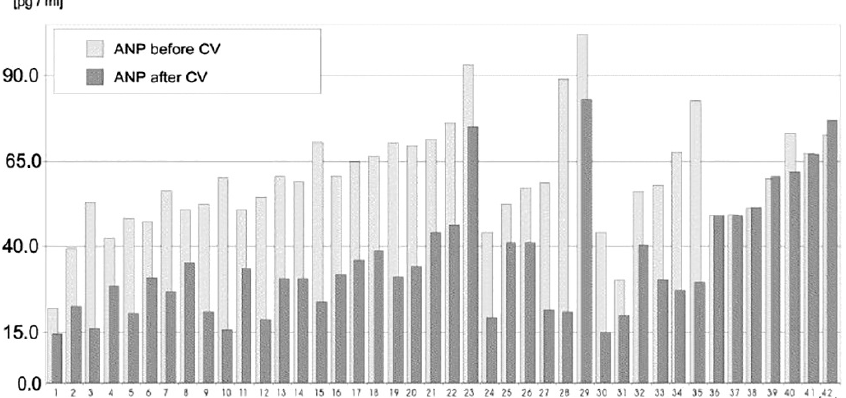
Figure 5. ANP levels in patients with AF before and after cardioversion (cardioversion in patients 36–42 was unsuccessful) [43].